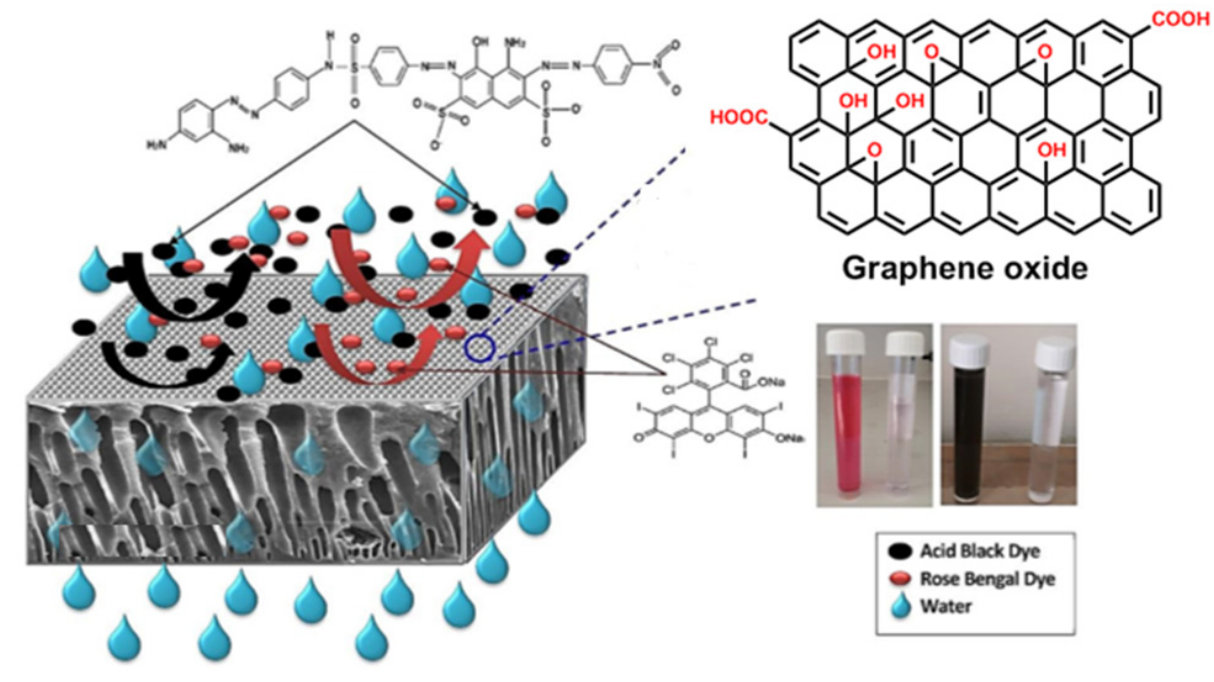
Figure 1. Dye removal using graphene oxide (GO) mixed matrix membranes [87].